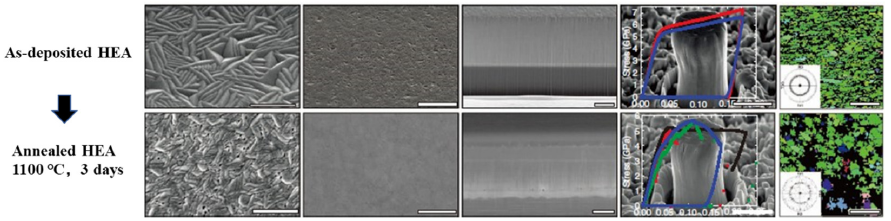
Figure 2. Comparison of the microstructures of NbMoWTa refractory high entropy alloy films after 72 h heat treatment at 1100 °C (scale bars, the first column 200 nm, last column 300 nm, other images 1 µ m) [36].